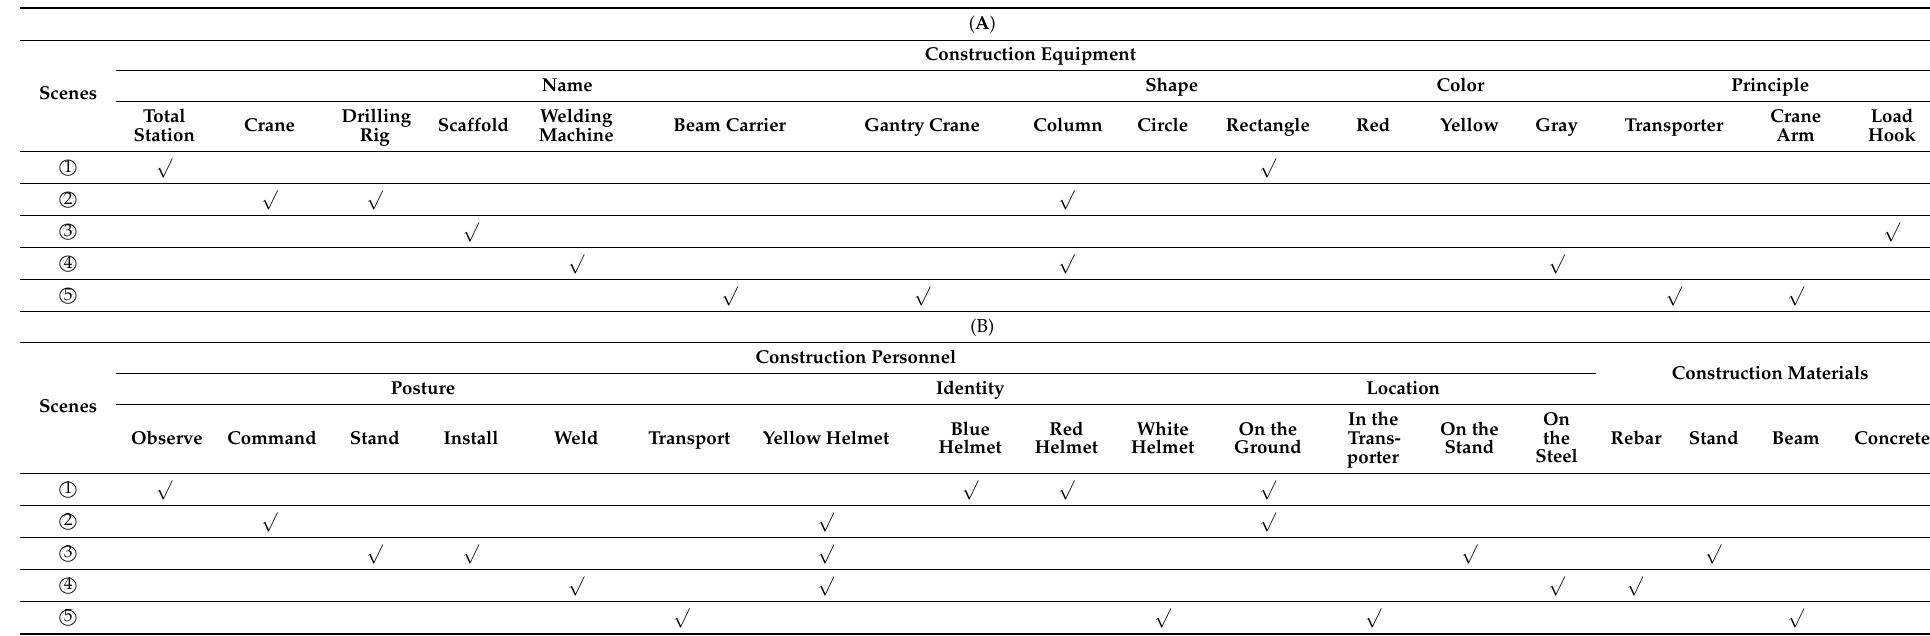
Table 1. ( A ) Construction equipment in five scenes; ( B ) Construction personnel and construction materials in five